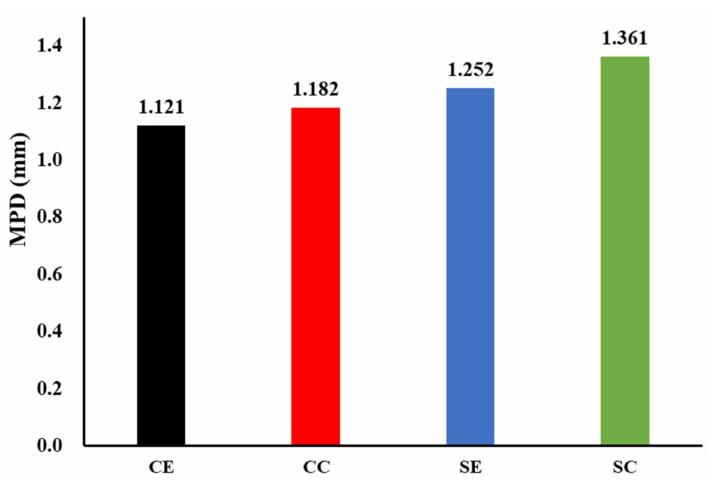
Figure 11. The results of